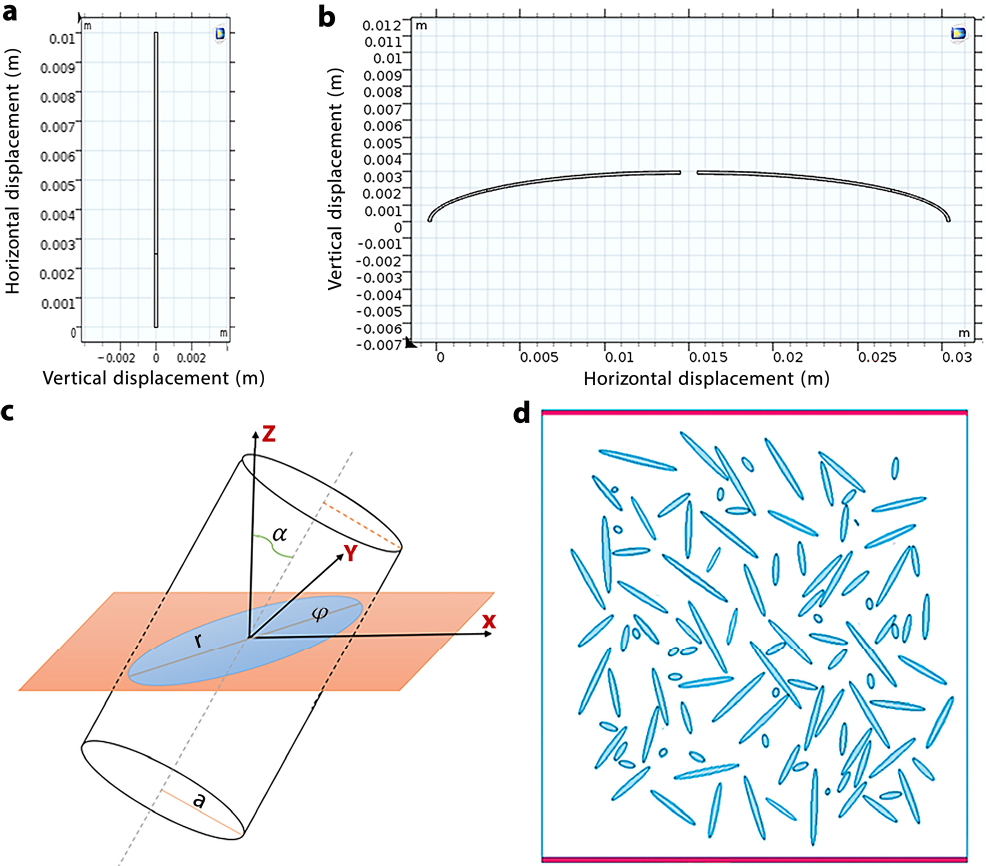
Figure 2. ( a , b ) show the IPMC strips designed for models A and B, respectively. ( c ) Spatial distribution of CNT on its elliptical cross-section. ( d ) The cross-section of a nanocomposite CNT based and distribution of CNT.